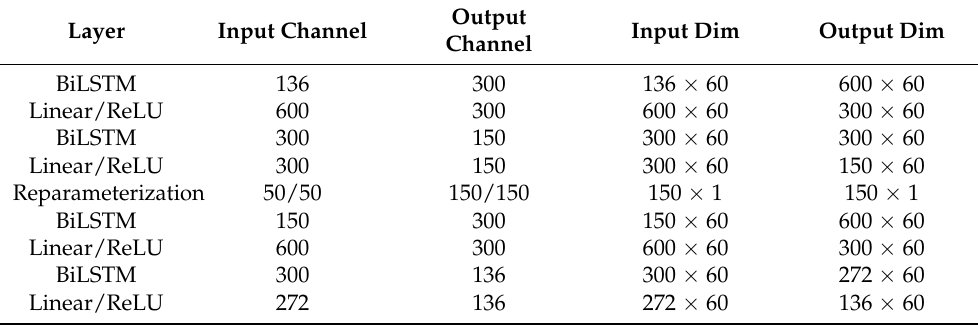
Table 9. The structure of the DLAN model for chlorobenzene production process.